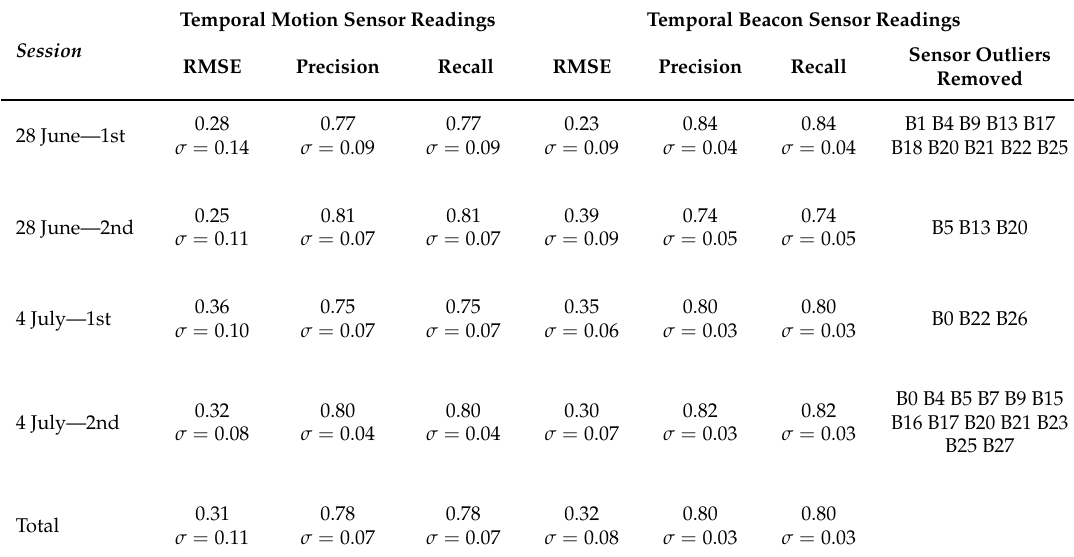
Table 7. TSR analysis for W = 7